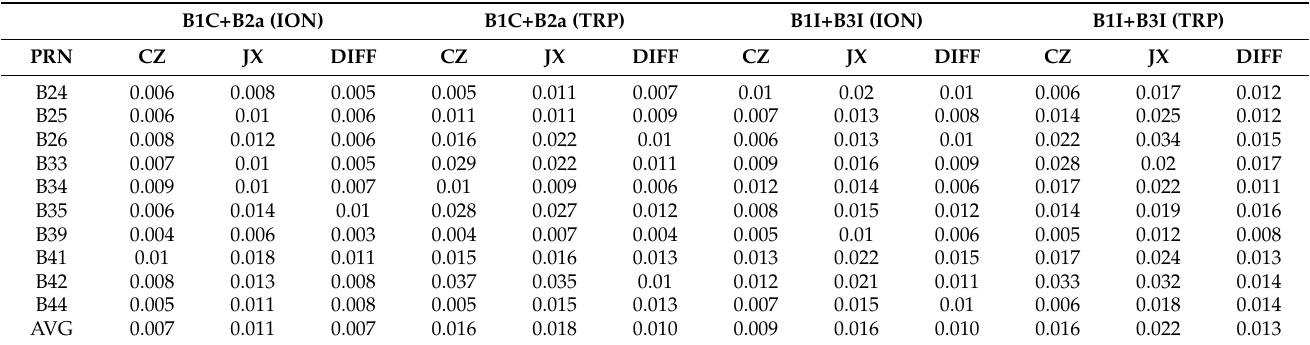
Table 5. RMS Statistics of atmospheric modeling values and reference values at Station SC17 under different frequency signal combinations (m).